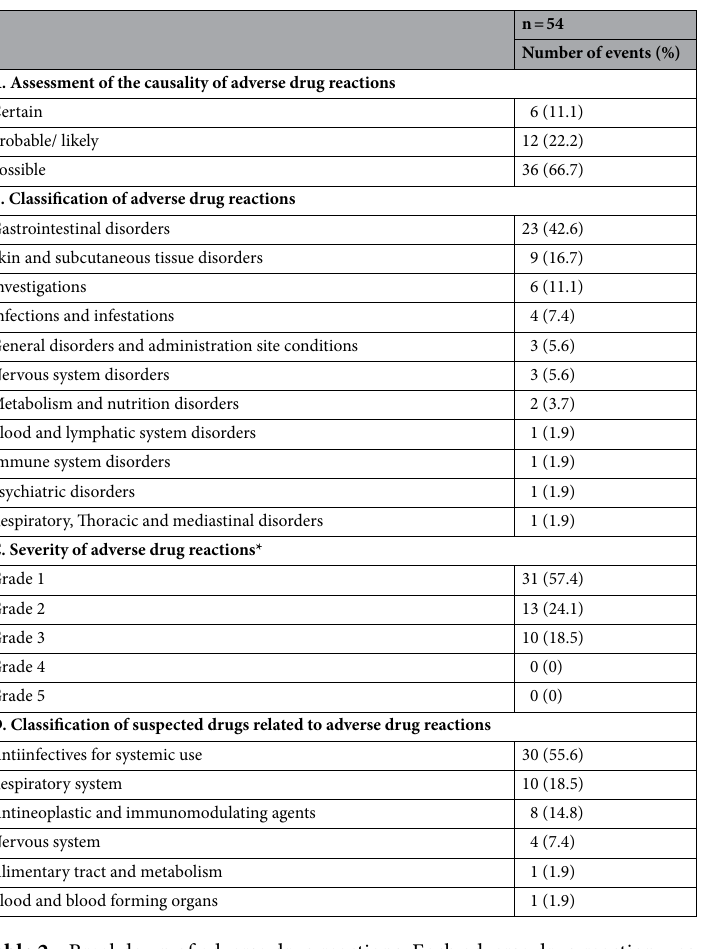
Table 2. Breakdown of adverse drug reactions. Each adverse drug reaction was counted, even when there is more than one adverse drug reaction per patient. *Grade refers to the severity of the adverse events according to Common Terminology Criteria for Adverse Events v5.0. Grade 1: Mild; asymptomatic or mild symptoms; clinical or diagnostic observations only; intervention not indicated. Grade 2: Moderate; minimal, local or noninvasive intervention indicated; limiting age appropriate instrumental activities of daily life. Grade 3: Severe or medically significant but not immediately life-threatening; hospitalization or prolongation of hospitalization indicated; disabling; limiting self care activities of daily life. Grade 4: Life-threatening consequences; urgent intervention indicated. Grade 5: Death related to AE.